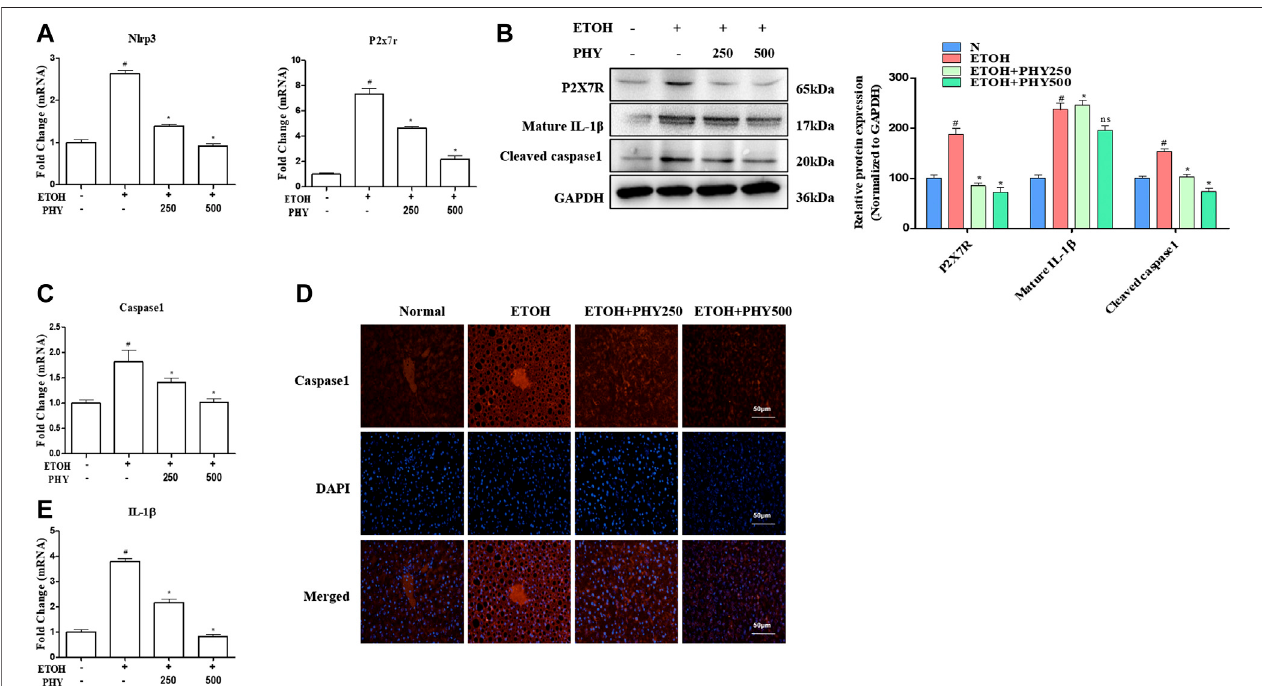
FIGURE 3 | Physcion suppresses in fl ammasome activation in ethanol-induced acute hepatic injury. (A) The mRNA expression of Nlrp3 and P2x7r. (B) The protein expression levels of P2X7R, and IL-1 β . (C) The mRNA expression of Caspase1. (D) Caspase-1 staining (red) and nuclei with DAPI (blue) are shown. (E) The mRNA expression of IL-1 β . Values signi fi cantly different from the control are indicated by hash signs ( # p < 0.05). Values signi fi cantly different from the ethanol are indicated by asterisks (* p < 0.05).